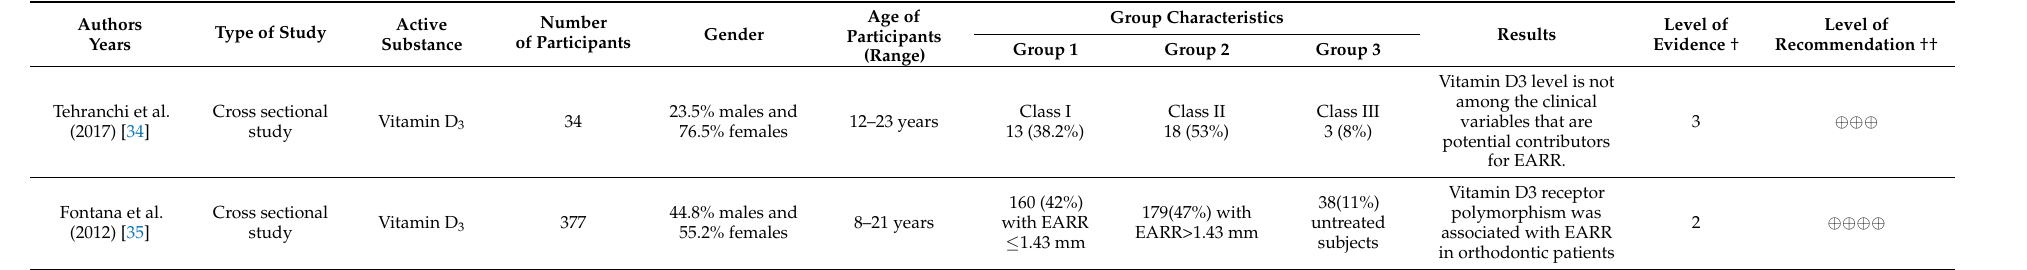
Table 3. The summary of studies that assessed relation between calcitriol level and external apical root resorption ( n =